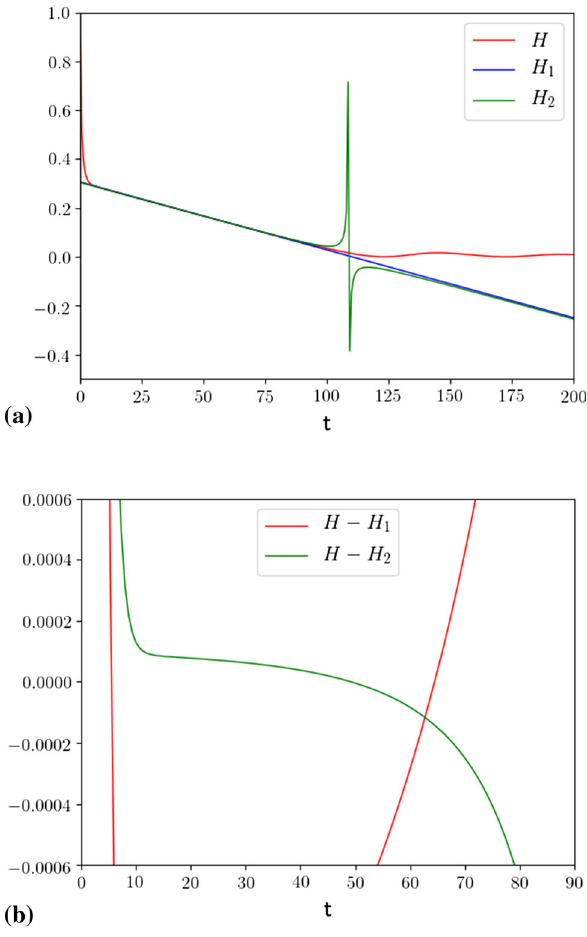
Fig. 2 a It is show in red the exact numeric solution of Eq. (19) for β = − 10, H ( t ) . The perturbative approximations are plotted in blue for the Eq. (22), H 1 ( t ) and in green for the Eq. (23), H 2 ( t ) . The initial conditionischosenas H ( 0 ) = 1, ˙ H ( 0 ) = − 1 . 66666,whiletheconstant t 0 = 110 . 2 in (22) and t 0 = 108 . 9 in (23) are fixed by best fitting. b The graph in red shows the difference between the exact numeric solution (19), H ( t ) and the analytical approximation (22), H 1 ( t ) . Plotted in green is the difference between the exact numeric solution (19), H ( t ) and the analytical approximation (23), H 2 ( t ) . It is possible to see a weak convergence for higher orders to the exact numerical solution in the regime of slow-roll